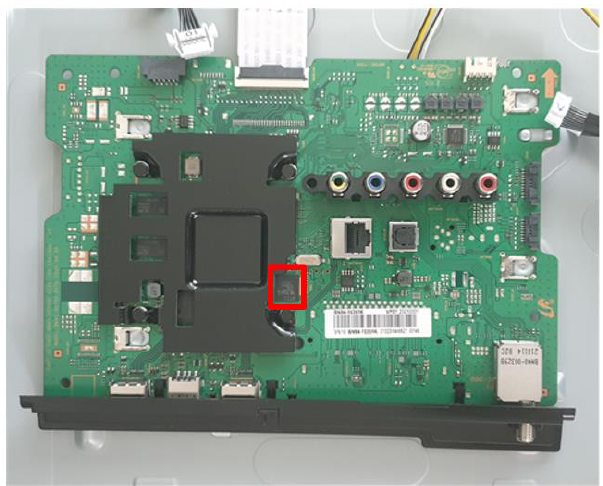
Figure 3. Nand flash chip (KU43T5300AFXKR) present on pcb of smart TV.